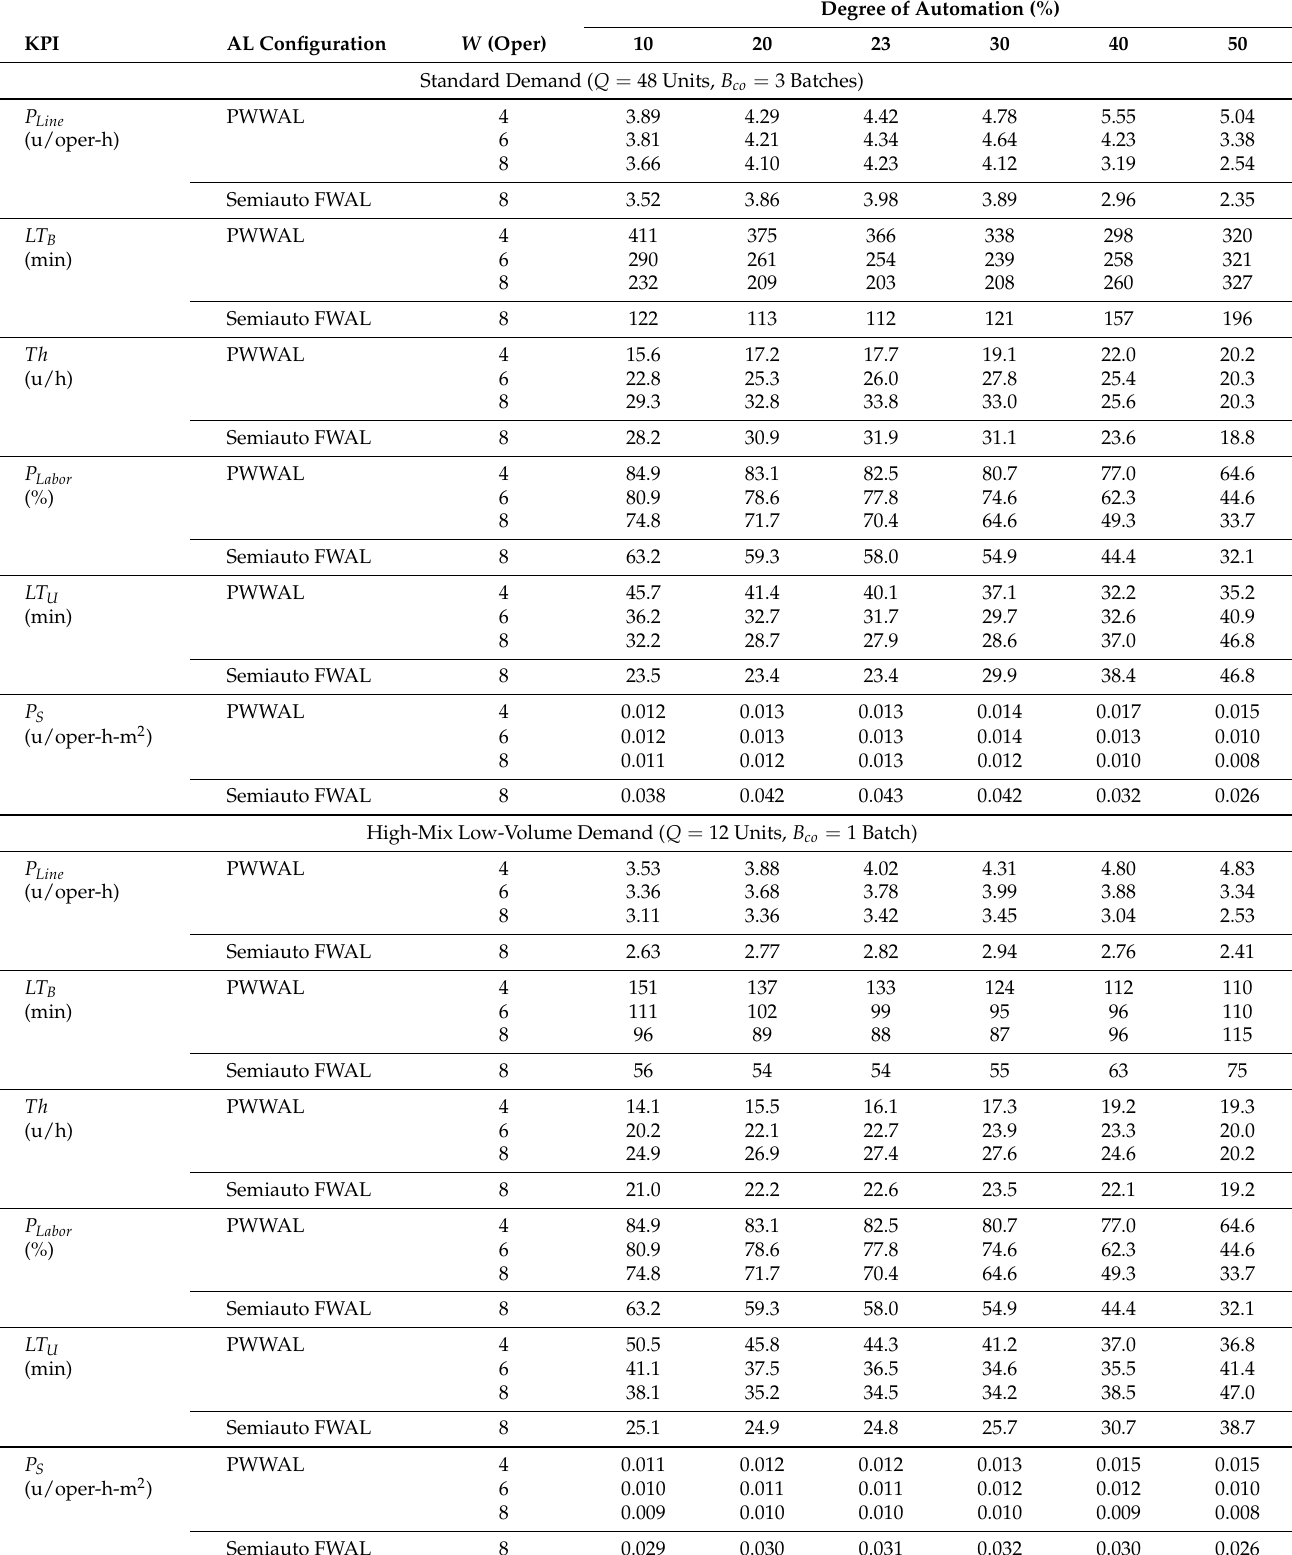
Table 12. Operational KPIs of semiautomated FWAL and PWWAL for varying degrees of automation and number of workers ( W ), under base or high-mix low-volume demand conditions ( Q , B co